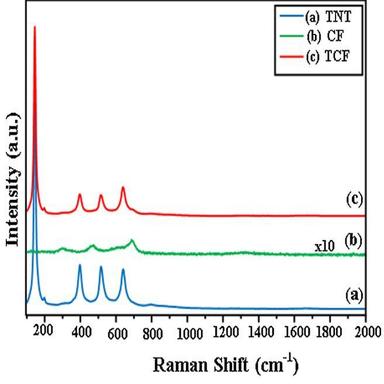
Raman spectra of the photocatalysts.